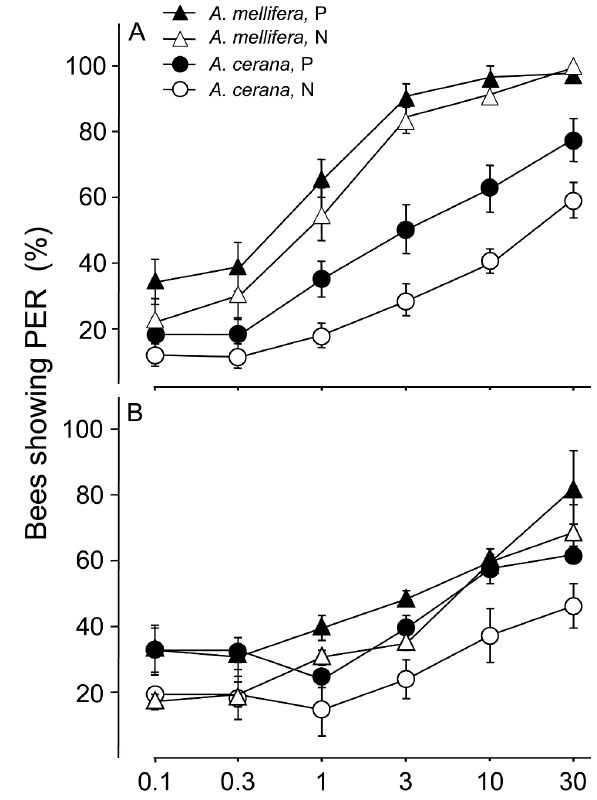
Figure 1. Percentage of bees showing proboscis extension response (mean+SE) of pollen (P, solid)